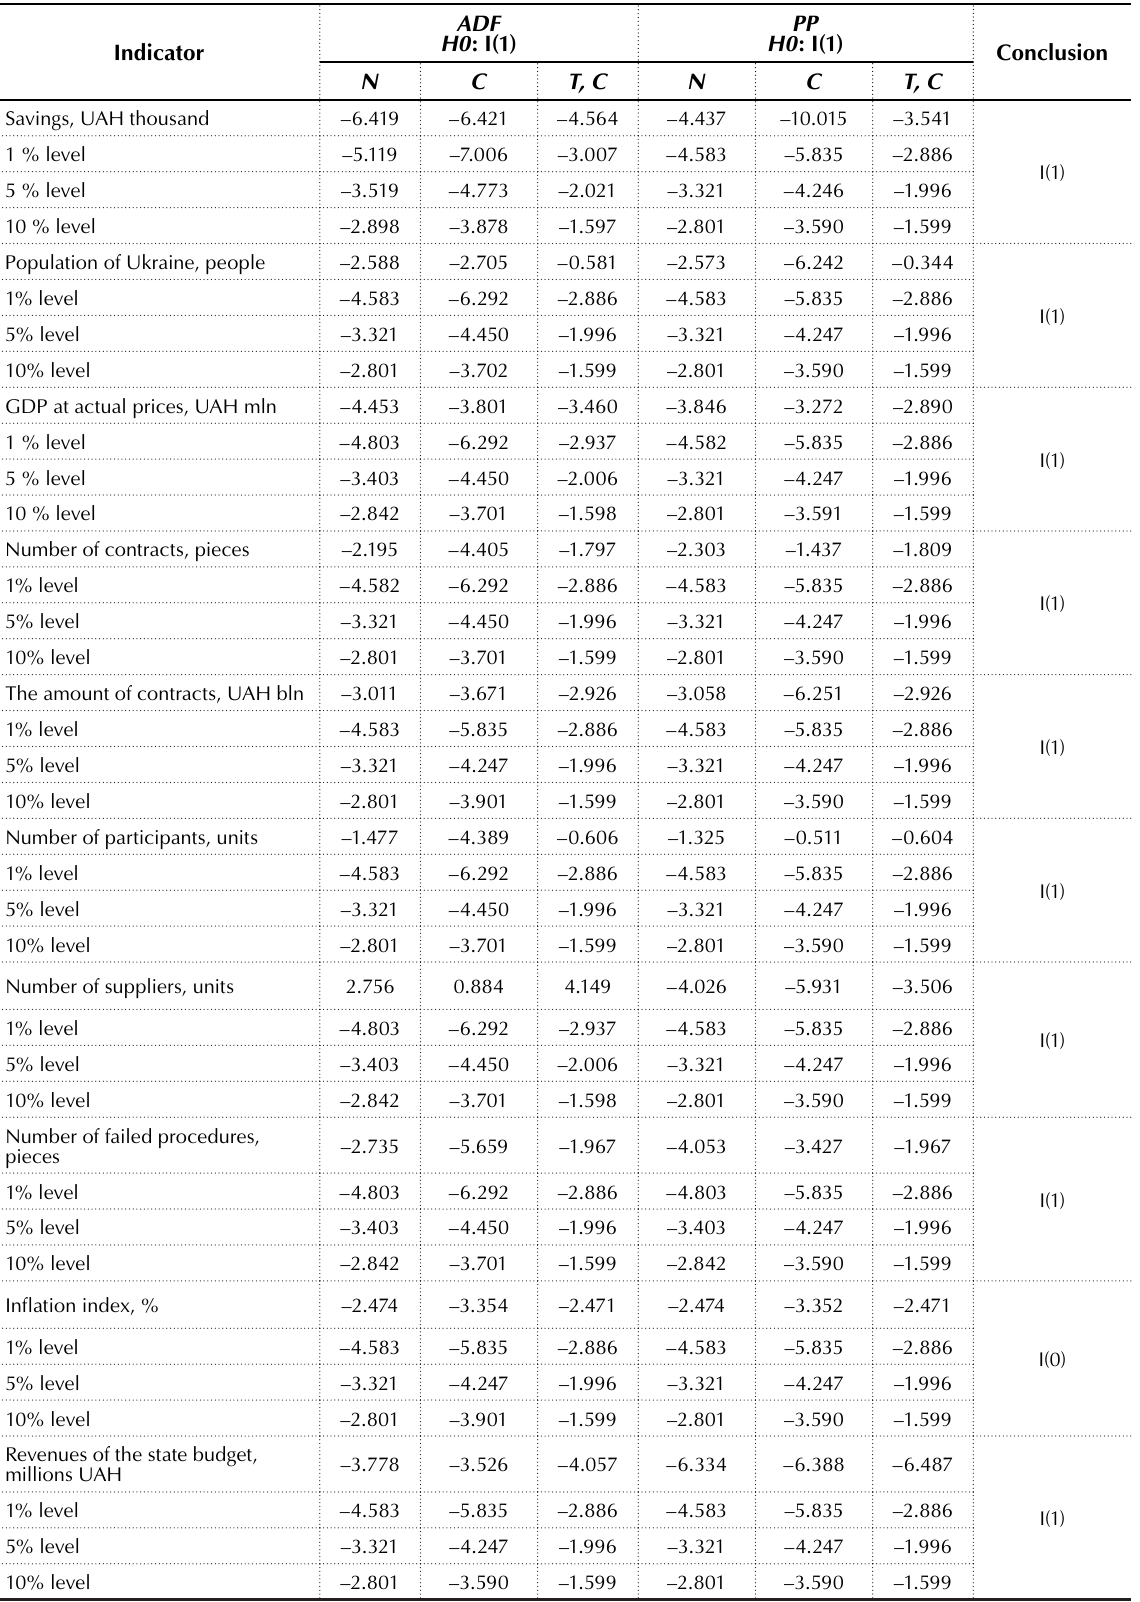
Table 3. Results of stationary research on the volume of savings in public procurement and factors that may affect